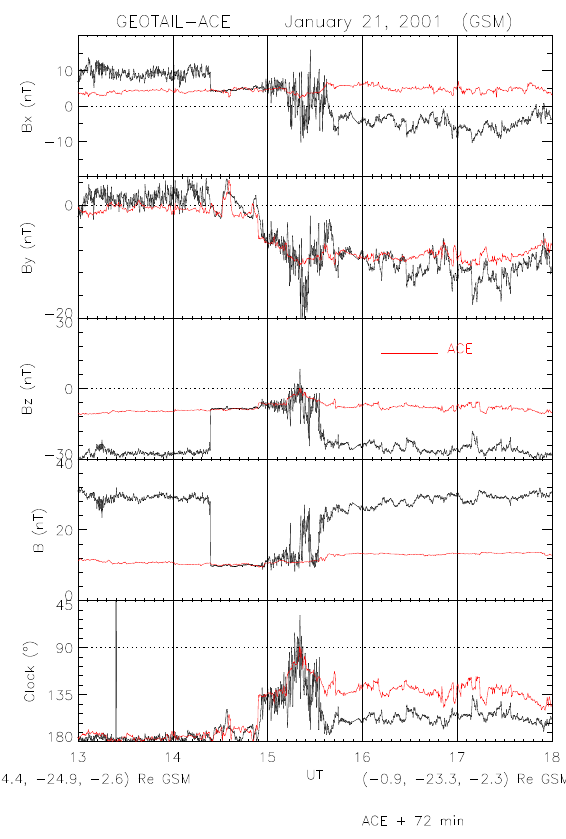
Fig. 2. An overlay of ACE (red trace) and Geotail magnetic field data. Geotail’s positions at the start and end times are given at the bottom. Geotail is alternately in the solar wind (when the two traces agree) and the magnetosheath. The excellent agreement in the (i) clock angle and (ii) B y at around 14:30–15:00 UT implies that the delay of 72min used in the overlay is reliable.